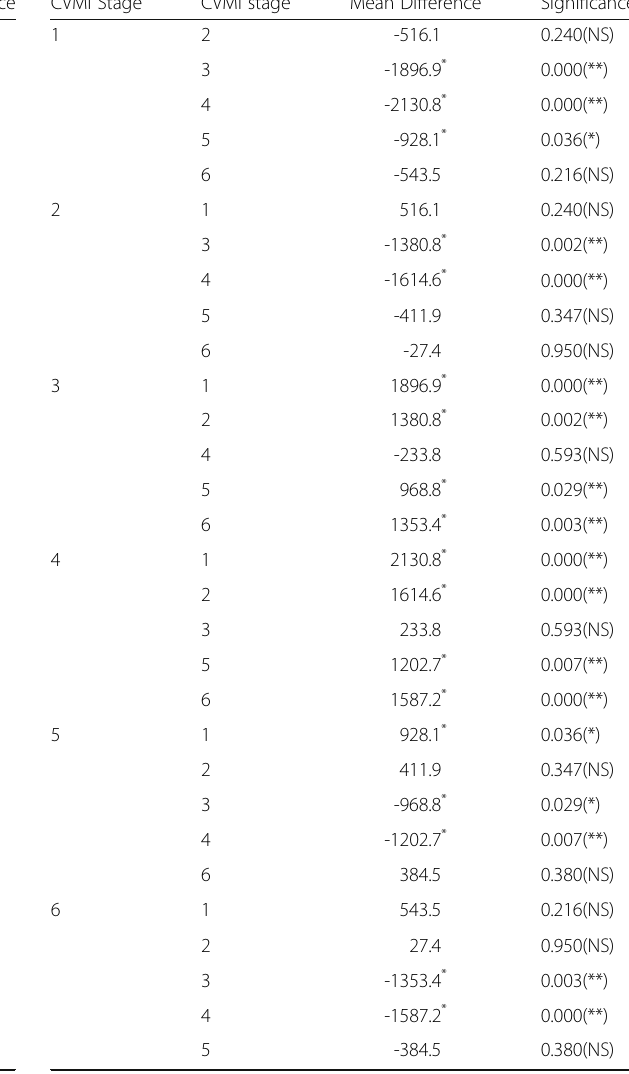
Table 4 The Post-hoc analysis (least significant difference) comparing IGFBP-3 serum levels for each of the 6 CVMI